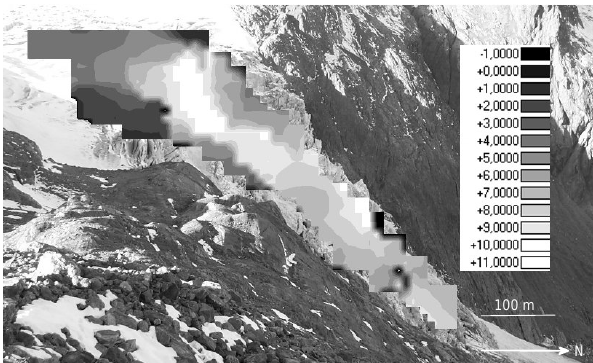
Fig. 16. Surface flow velocity field for Triftgletscher inferred from pictures taken with the upper camera: image-related displacements during a week in late summer 2005 in grey-coded representation (displacements in pixels/7